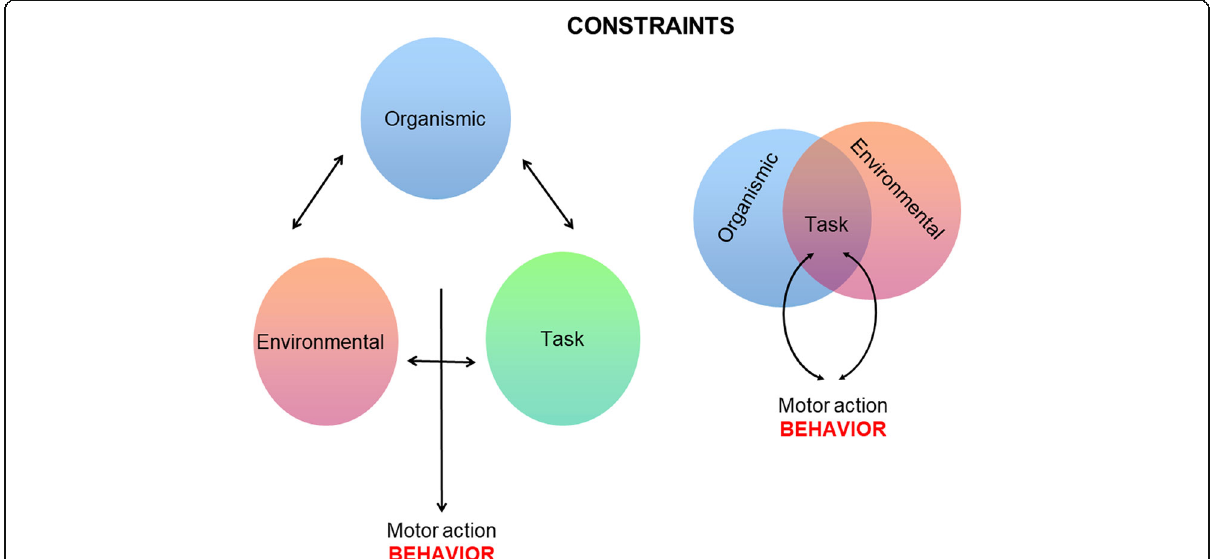
Fig. 1 Left: Newell ’ s model [5]; organismic, environmental, and task constraints as independently defined interacting entities. Right: organismic and environmental constraints as independently defined interacting entities, and task constraints as emergent properties of the organism – environment